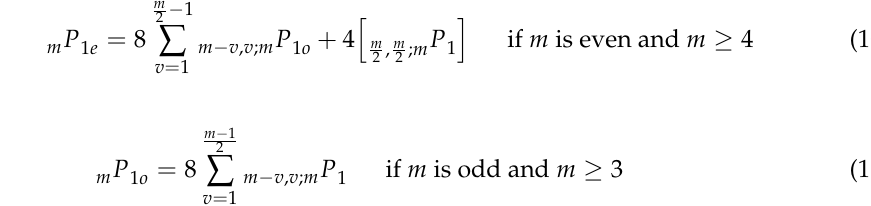
Table 6. GEA in (Equation (1)) for samples of four lacking one gene. Num. Sample Num. Sample Num. Sample Num.